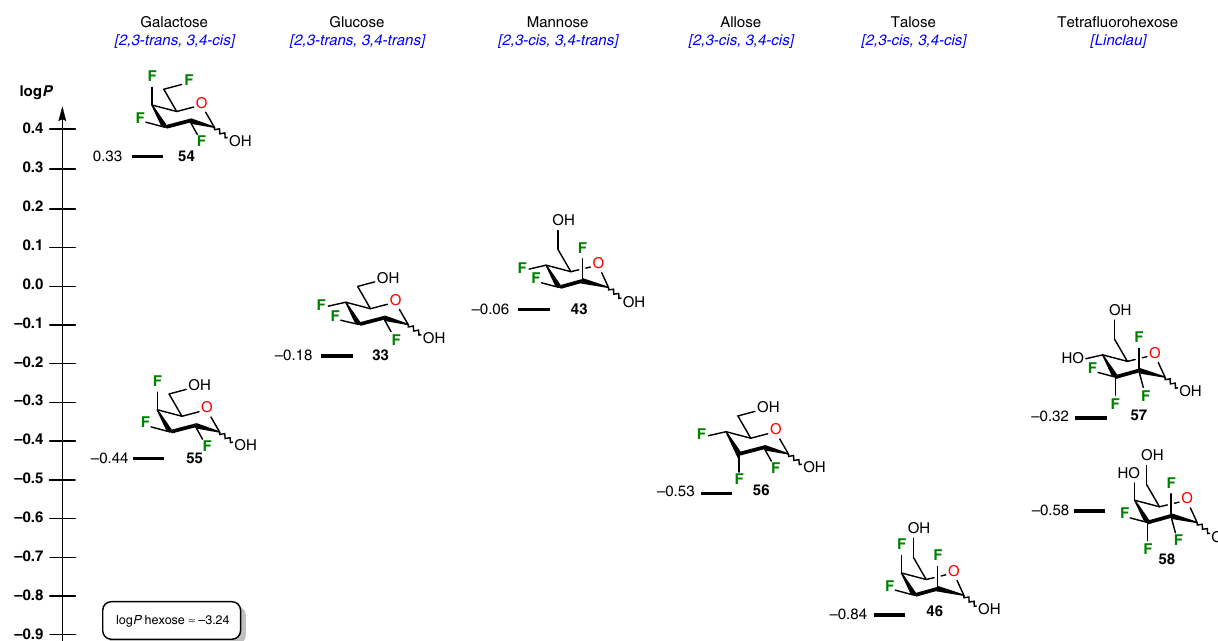
log P hexose ≈ –3.24 Fig. 9 Lipophilicities of fl uorinated carbohydrates. Compounds 33 , 43 , 46 , 54 − 56 were prepared in this study and tetra fl uorohexose analogs 57 and 58 were synthesized by the group of